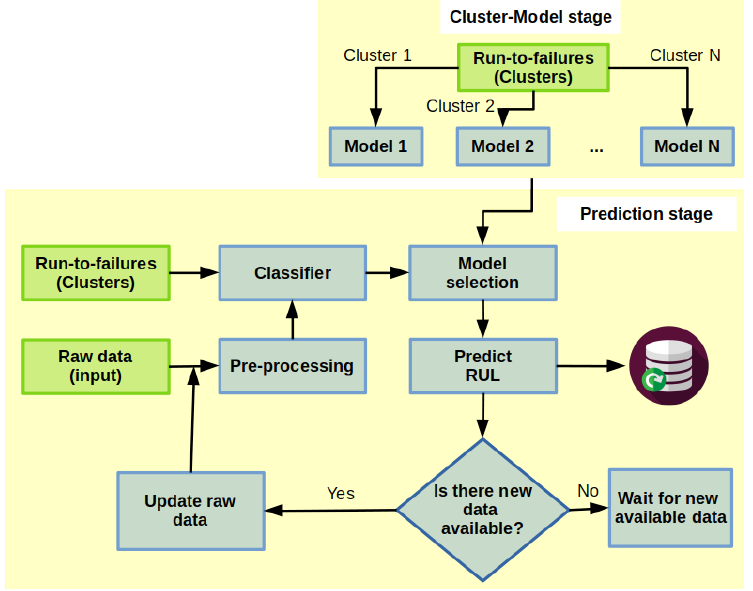
Figure 7. Prognostic process: strategy